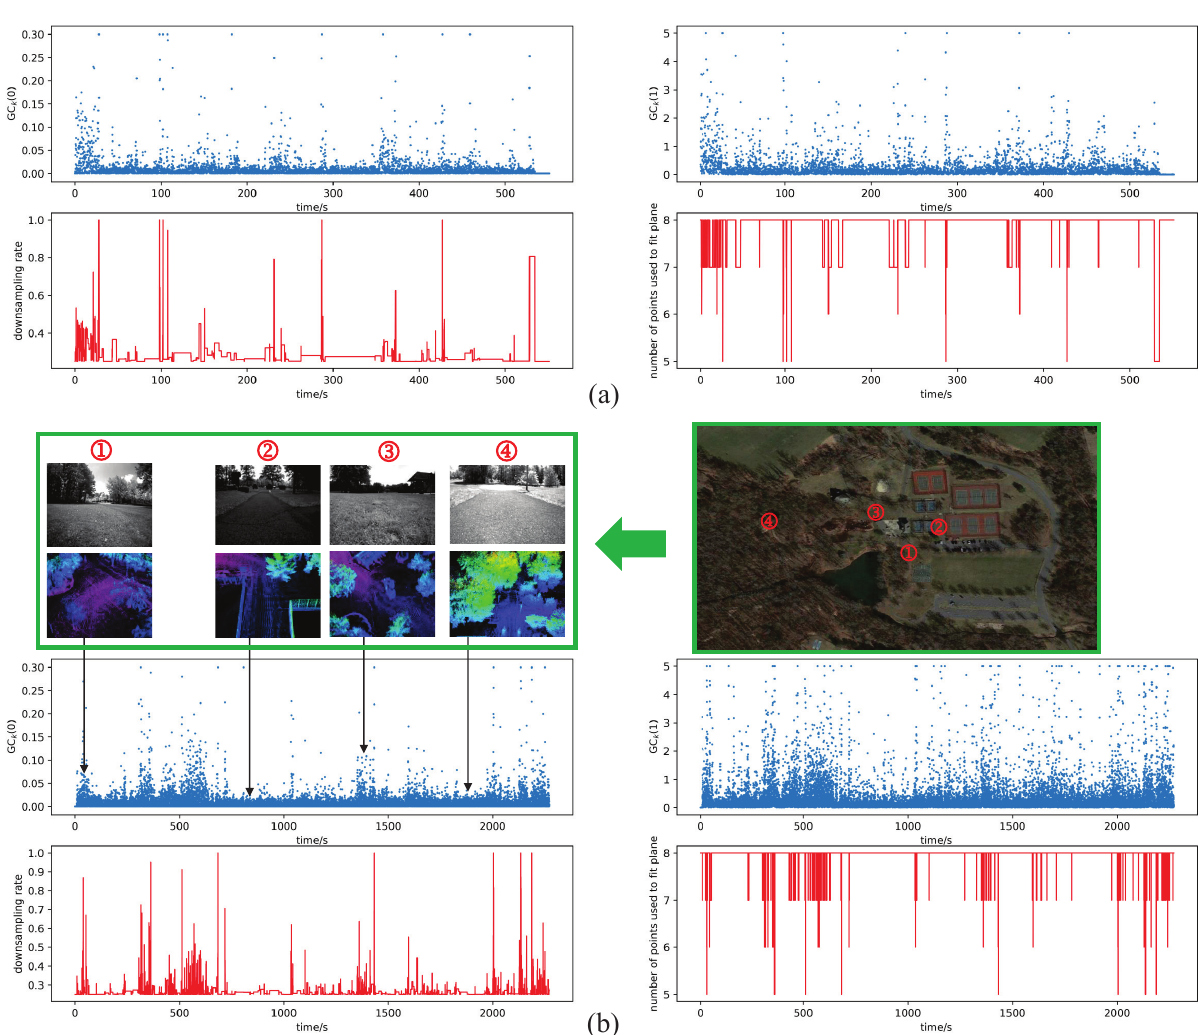
Figure 4. The changing process of the ground condition vectors, the downsampling rate of lidar points and the number of map points used to fit plane. ( a ) The situation in small-scale dataset of 500 s, 0.7 km. ( b ) The situation in large-scale dataset of 2200 s, 4.6 km. The pictures of ground are shown on the upper left of ( b ) as the visual information is included in the large-scale dataset, and the corresponding lidar point cloud maps are also provided below these pictures to reflect the ground conditions in detail. The picture on the upper right of ( b ) shows the locations of the ground condition in Google satellite